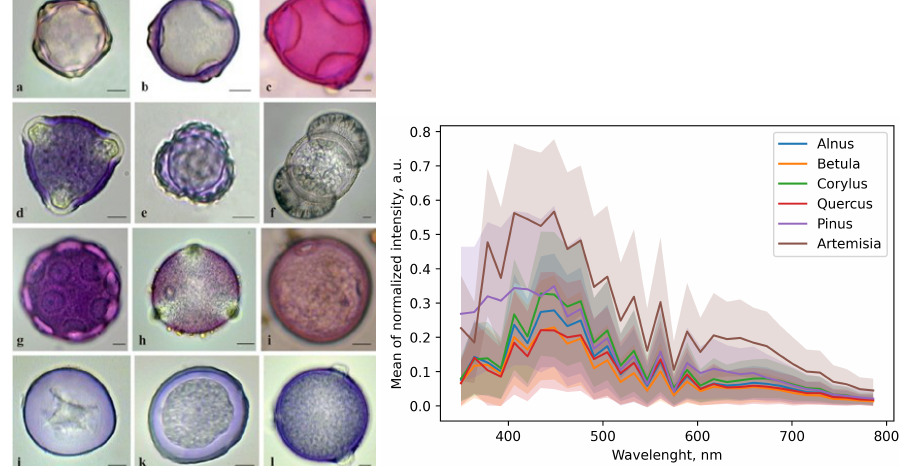
Figure 8. On the left, images of different pollen species on microscope slides [23]: ( a ) Alnus glutinosa , ( b ) Betula pendula , ( c ) Corylus avellana , ( d ) Quercus robur , ( e ) Ambrosia artemisiifolia , ( f ) Pinus sylvestris , ( g ) Juglans regia , ( h ) Acer sp., ( i ) Poa ., ( j ) Taxus baccata , ( k ) Ulmus sp. and ( l ) Fagus sylvatica . On the right, the average fluorescence spectrum for some of the classes present in SAU-LI.